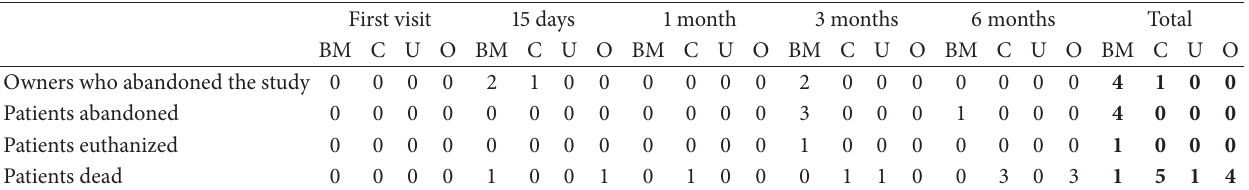
Table2:Numberofownerswhoabandonedthestudyandnumberofpatientsabandoned,euthanized,anddead(BM=behaviouralmedicine; C = cardiology; U = urology; and O = oncology).